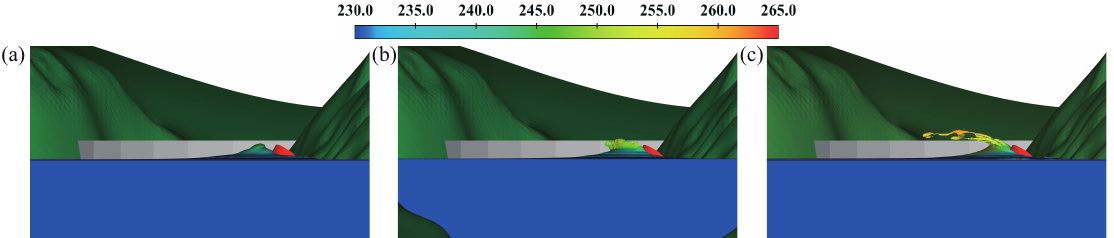
Figure 11. Highest initial wave in the near field at t = 10 s: ( a ) 6-m global uniform mesh; ( b ) 3-m global uniform mesh; and ( c ) mesh-scheme solution.